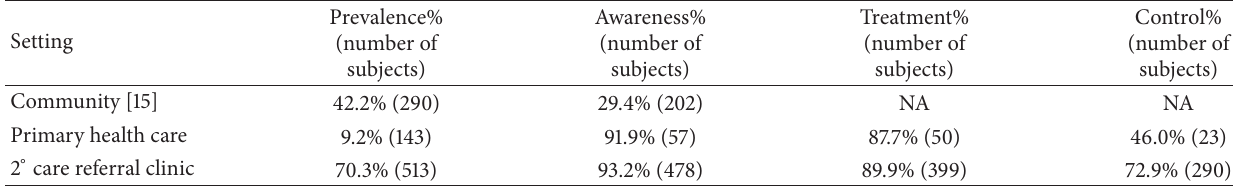
Table 1: Comparison of rates of hypertension prevalence, awareness, treatment, and control in the local market community, primary health care, and secondary care referral